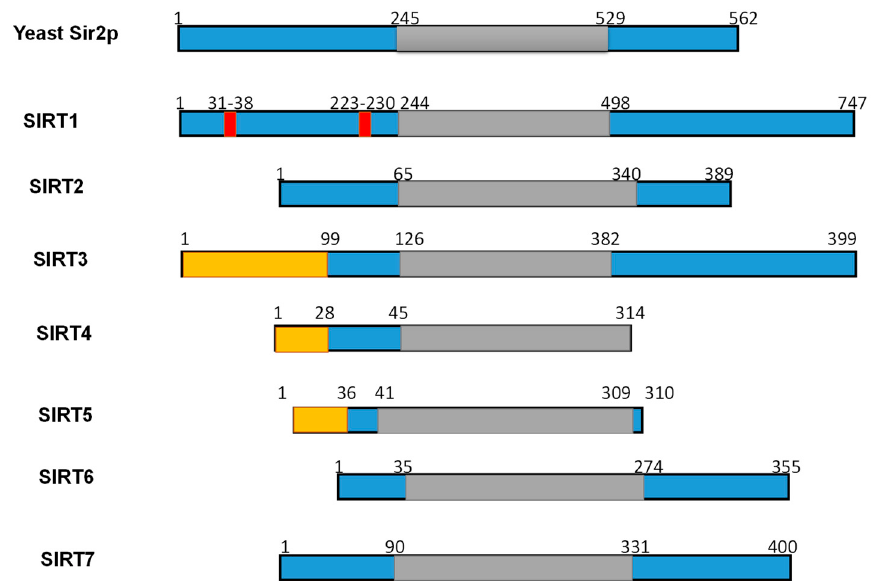
Figure 2. Schematic overview of human SIRTs (SIRT1–7). Human SIRTs are aligned with yeast Sir2p. The conserved large catalytic domain is shown in grey. The nuclear localization sequences shown in red and the mitochondrial targeting sequences are shown in dark yellow. Numbers refer to amino acid residues in the proteins. Adapted from Ref. [9].